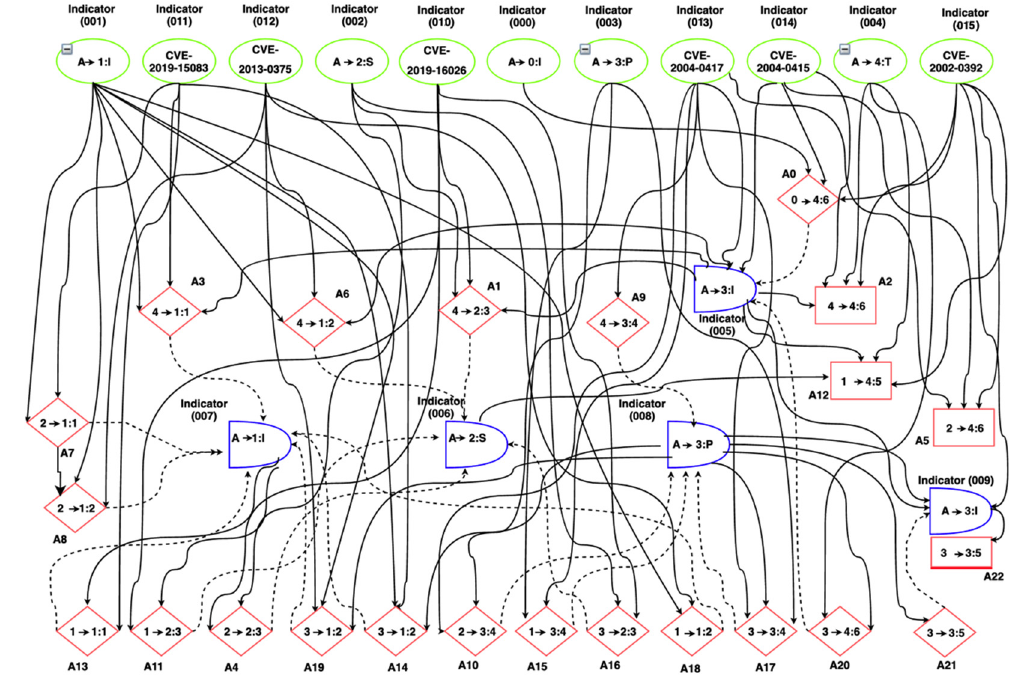
Figure 10. The attack graph with the corresponding factors’ codes.